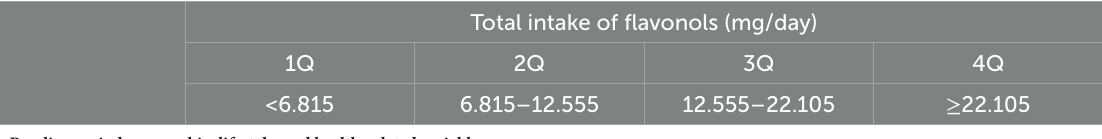
TABLE 1 Relevant baseline variables according to the total flavonol intake